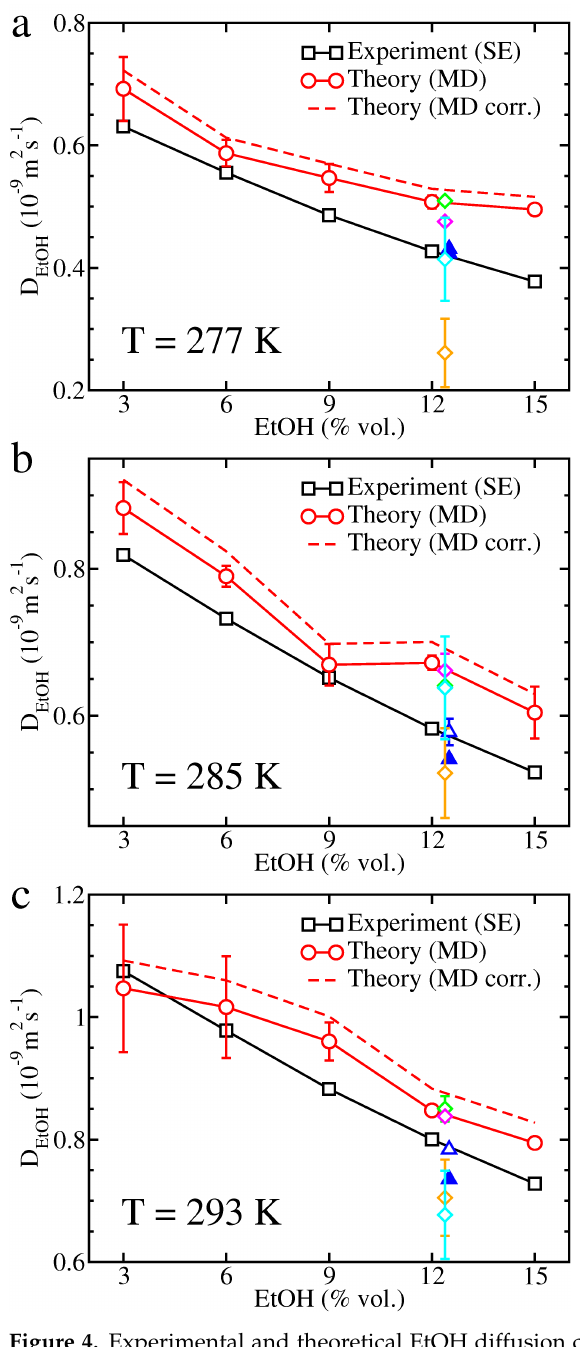
Figure 4. Experimental and theoretical EtOH diffusion coefficients in carbonated hydroalcoholic solutions at ( a ) T = 277 K, ( b ) T = 285 K, and ( c ) T = 293 K. The definition of symbols and colors is the same as in Figure